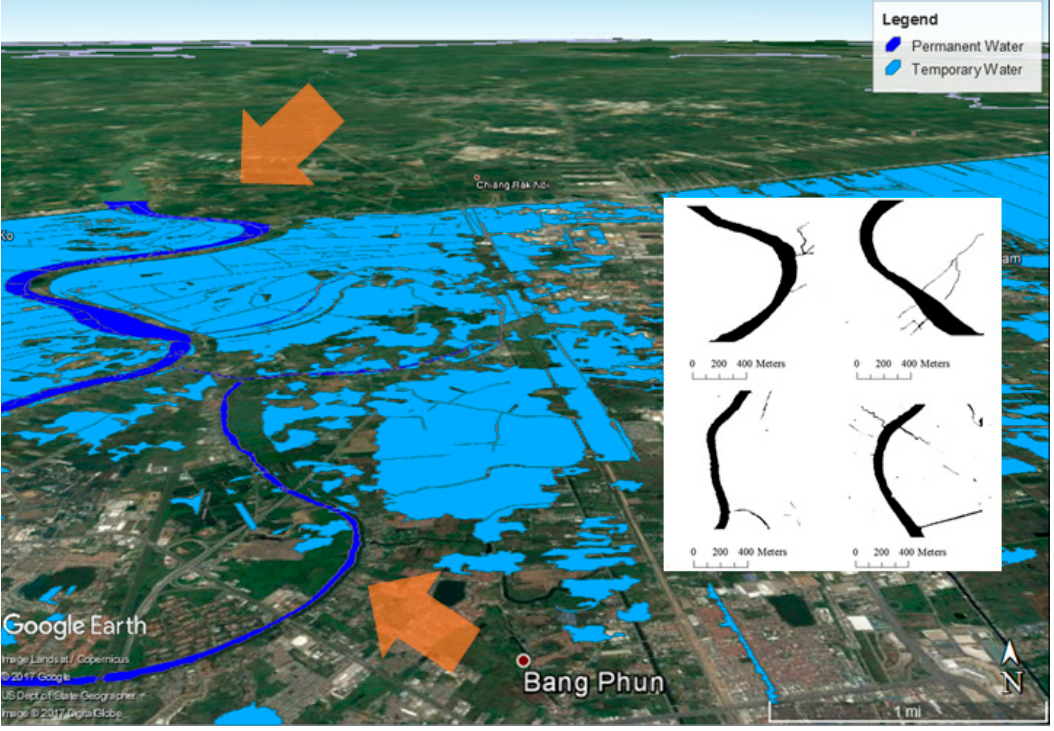
Figure 8. Discrimination between the Chaophraya River in dark blue and the flooded areas light blue in Pathumthani.